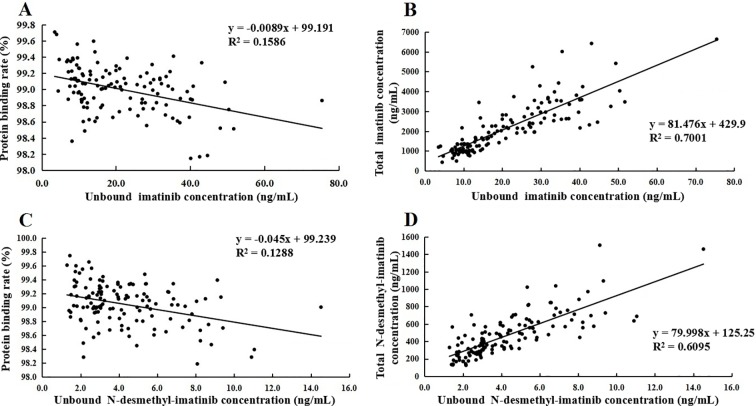

(A) Association of unbound imatinib concentration and plasma protein binding rate. (B) Association of unbound N-desmethyl-imatinib concentration and plasma protein binding rate. (C) Association of total imatinib concentration and unbound imatinib concentration. (D) Association of total N-desmethyl-imatinib concentration and unbound N-desmethyl-imatinib concentration.